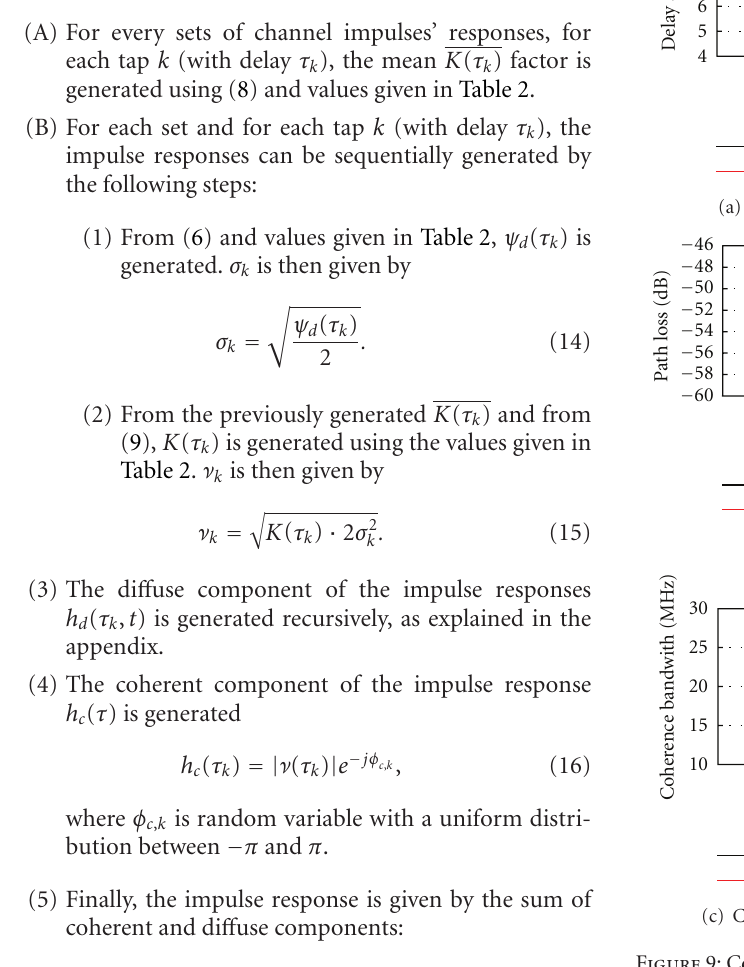
Figure 9: Comparisons between simulated and measured channels. The parameters extracted from the simulations do not di ff er significantly from the measurements. Mean values agree well, and the standard deviations do not di ff er